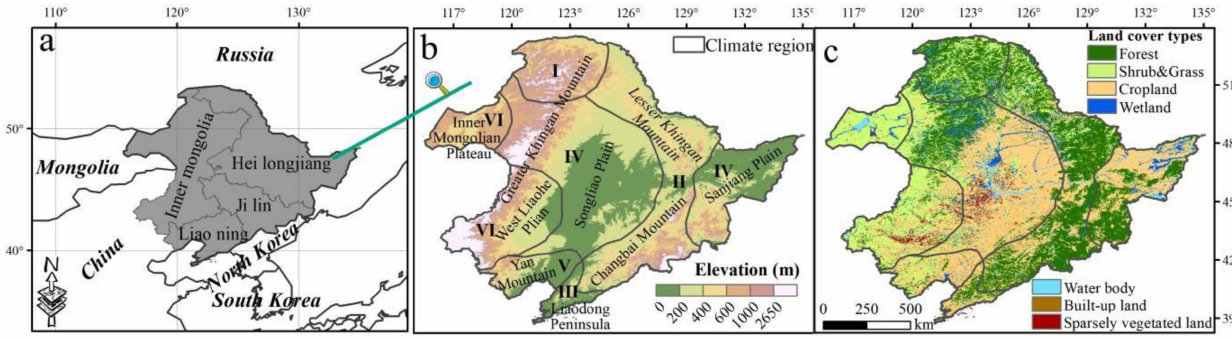
Figure 1. Location ( a ), elevation and climate regions ( b ), and land cover types ( c ) of northeast China (NEC). The elevation data in a 30 m spatial resolution was obtained from the Data Center for Resource and Environmental Sciences of the Chinese Academy of Sciences (http://www.resdc.cn/, accessed on 11 March 2021). Land cover data were derived from the “plant functional type map” of China in a 1 km spatial resolution, which was obtained from the National Tibetan Plateau Data Center (https://data.tpdc.ac.cn/, accessed on 11 March 2021). Table 1. Main characteristics of climate regions in northeast China